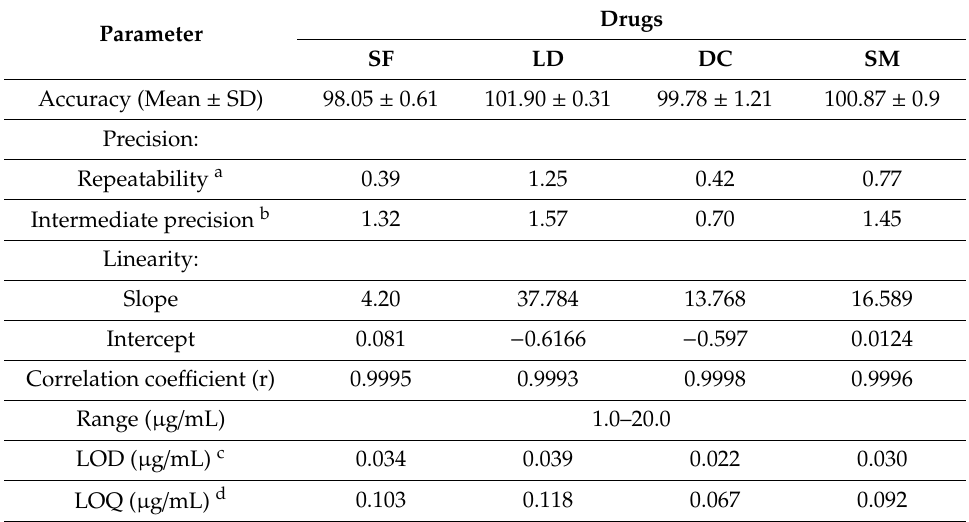
Table 3. Regression and analytical parameters of the proposed HPLC method for the determination of SF, LD, DC, and SM .